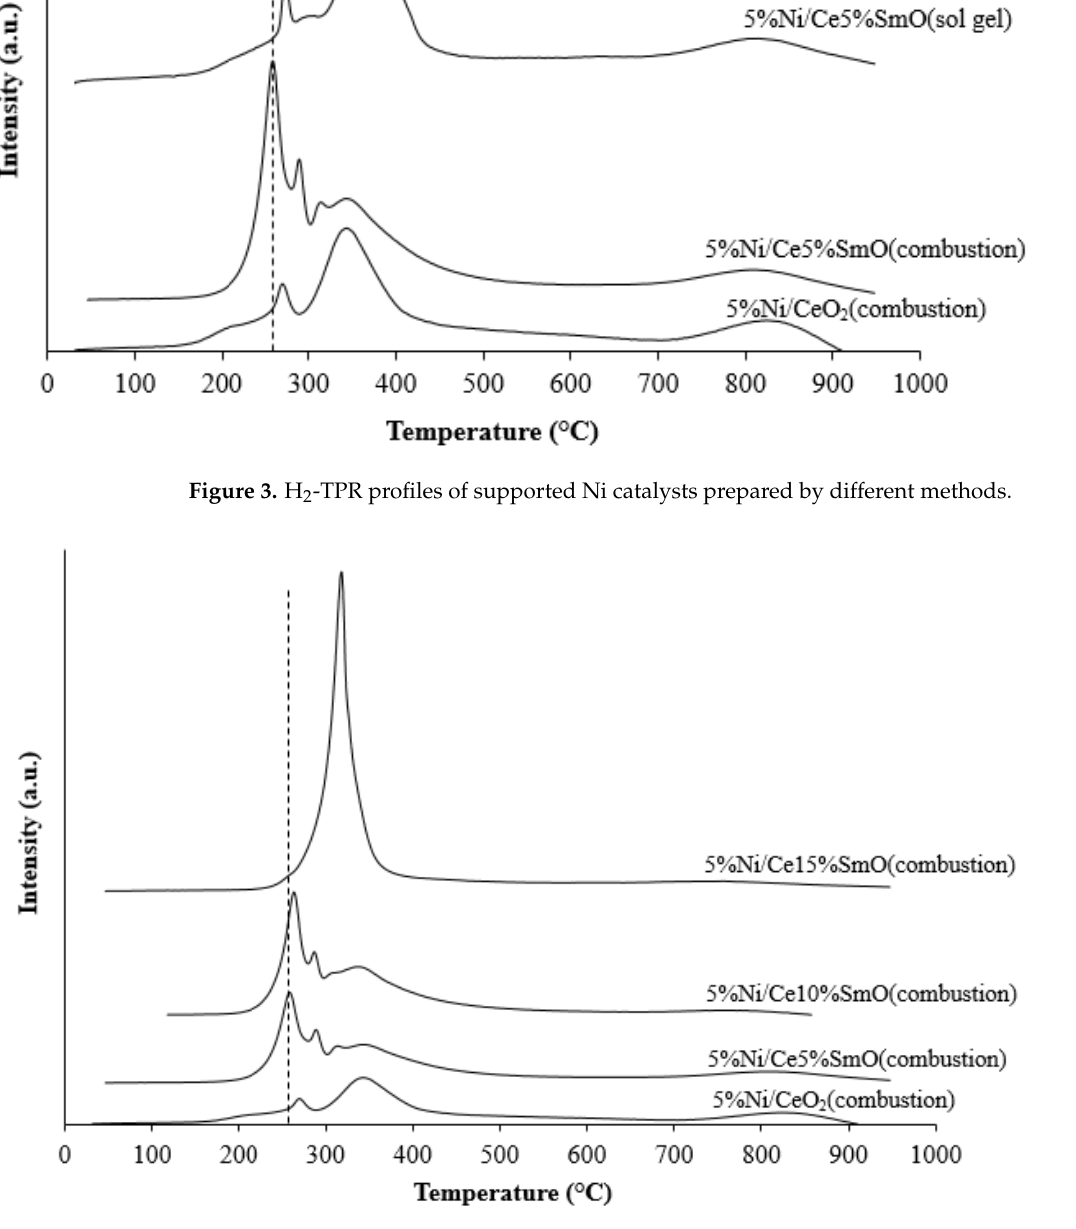
Figure 4. H 2 − TPR profiles of supported nickel catalysts prepared by combustion method under different samarium loading.